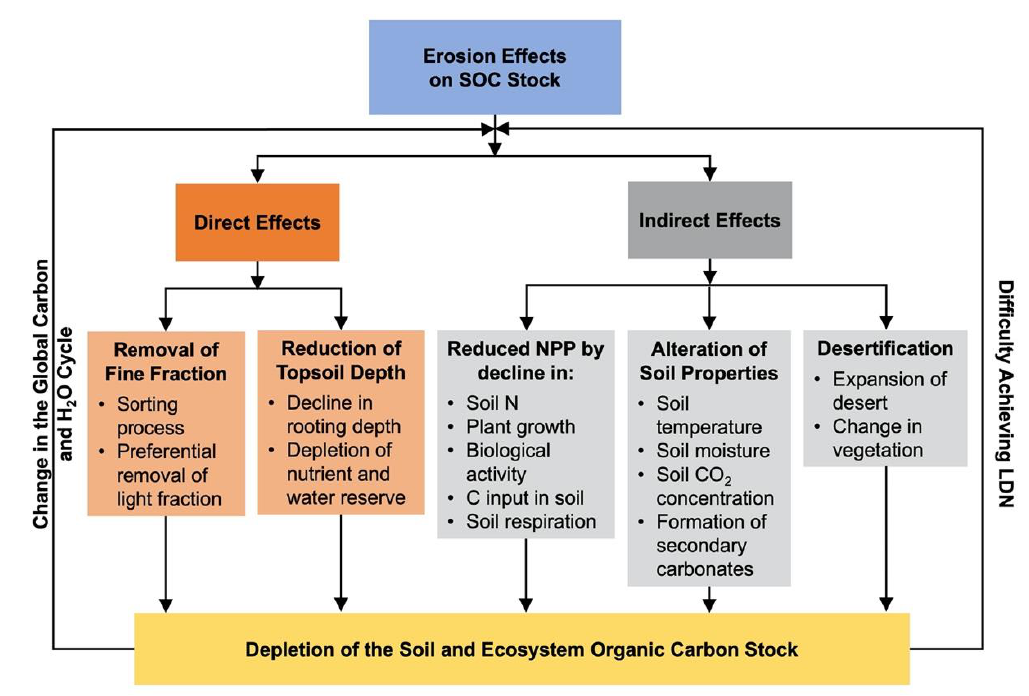
Figure 3. Effects of accelerated soil erosion on the global carbon cycle and the increase in the daunting challenge of achieving land degradation neutrality. Table 1. Examples of regional, national, or global terrestrial soil organic carbon (SOC) erosion by water and other processes.